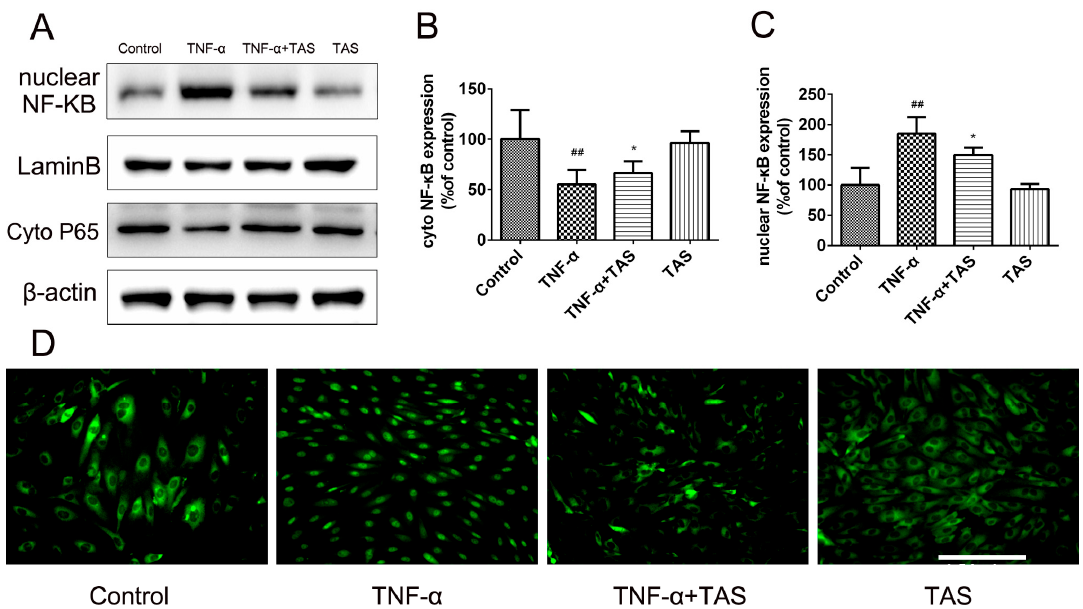
Figure 7 . TAS protected against HUVEC damage triggered by TNF- α via the NF- κ B pathway. HUVECs were preincubated with TAS (5 μ g/mL) for 2 h, followed by treatment with TNF- α (50 ng/mL) for 24 h. ( A ). The levels of NF- κ B p65 in the nucleus and cytoplasm. ( B ) Quantitative analysis of NF- κ B p65 expression in the cytoplasm. ( C ) Quantitative analysis of NF- κ B p65 expression in the nucleus. ( D ) The location of NF- κ B p65 was observed by immunofluorescent staining. The data are expressed as the mean ± SD of three independent experiments. ## p < 0.01 versus the control group; * p < 0.05 versus the TNF- α -treatment group. Scale bars, 50 μ m.